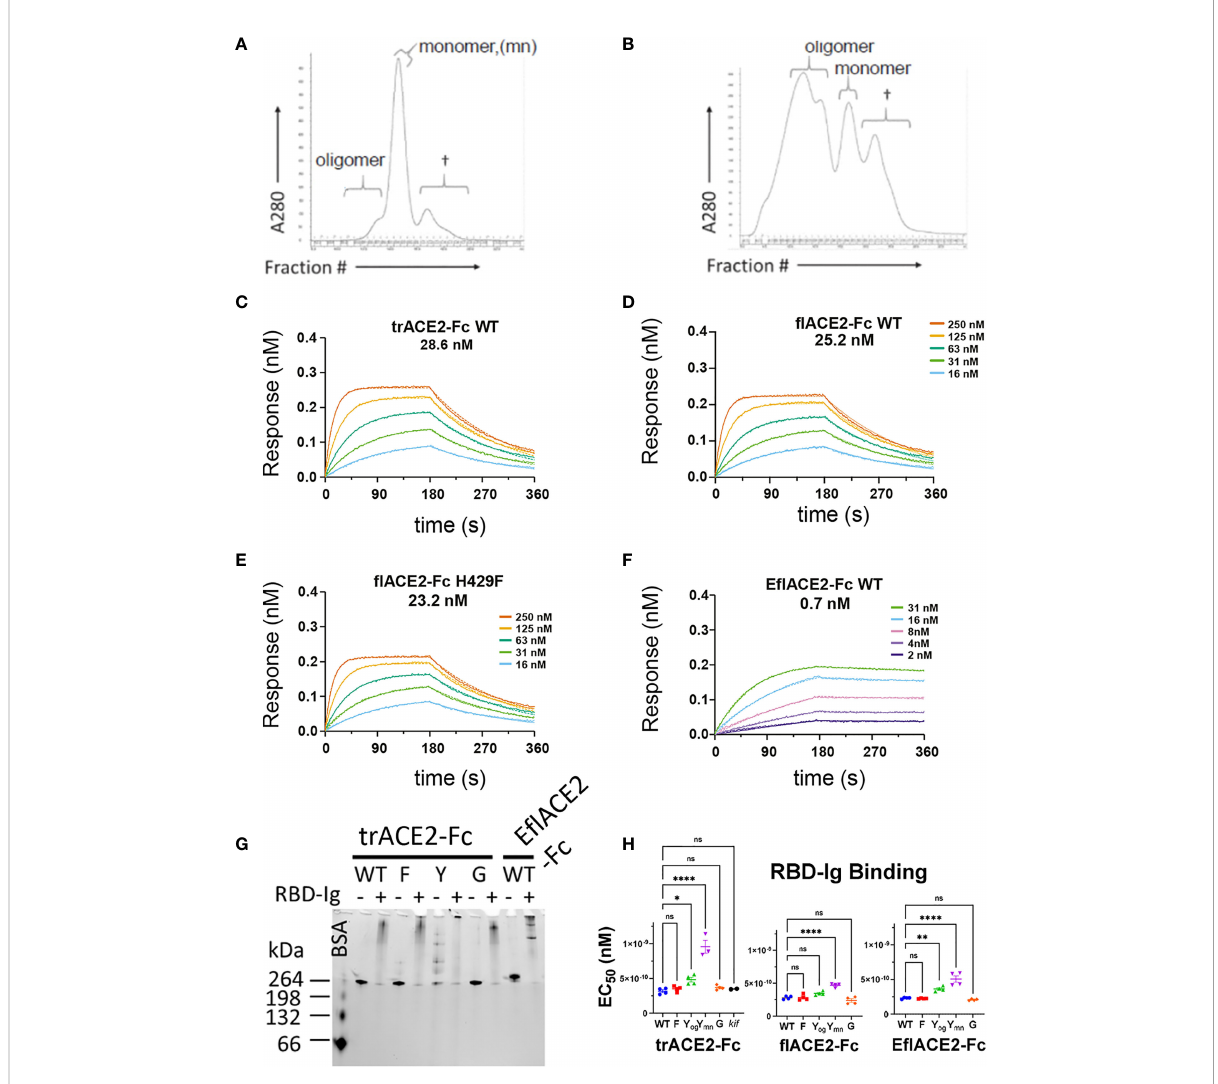
FIGURE 3 Characterization of engineered human fl ACE2-Fc and trACE2 – Fc fusion proteins. (A) Size-exclusion chromatography (SEC) of IEX fractions containing fl ACE2-Fc-WT using a Superose 6 column, with oligomeric, monomeric forms and low mw impurities ( † ) indicated; and (B) SEC of IEX fractions containing fl ACE2-Fc H429Y, showing the high proportion of oligomeric species. (C – F) Biolayer interferometry (BLI) analysis of ACE2-Fc proteins which were immobilized on anti-human Fc (BLI) sensors and reacted with the indicated concentrations of RBD. The dissociation constants, KD (nM), are derived from global fi tting of the association and dissociation curves to a Langmuir binding model. The ACE2-Fc proteins were, (C) trACE2-Fc WT (D) fl ACE2-Fc WT, (E) fl ACE2-Fc H429F and (F) the RBD binding-enhanced triple mutant of ACE2 fused to Fc; E fl ACE2-Fc WT (representative of n = 2 independent experiments). (G) Native Gel-shift analysis of ACE2-Fc proteins (1 mg, ~ 5 pmol) alone or combined with SARS-CoV-2 spike RBD-Ig (0.5 mg, ~ 5 pmol) and analyzed by native PAGE. The resulting shift in size of the proteins in the mixtures demonstrated the formation of ACE2-Fc: Cov2- RBD complexes. (H) Binding of different formats of ACE2-Fc-WT, and their Fc variants to immobilized RBD-Ig was determined by ELISA. EC 50 (nM) values are from agonist versus response curve fi ts,mean ± SD, n is indicated by individual symbols for each independent experiment. One-way ANOVA with Dunnett ’ s multiple comparisons test, p > 0.05 (ns), ≤ 0.05 (*), ≤ 0.01 (**), ≤ 0.0001